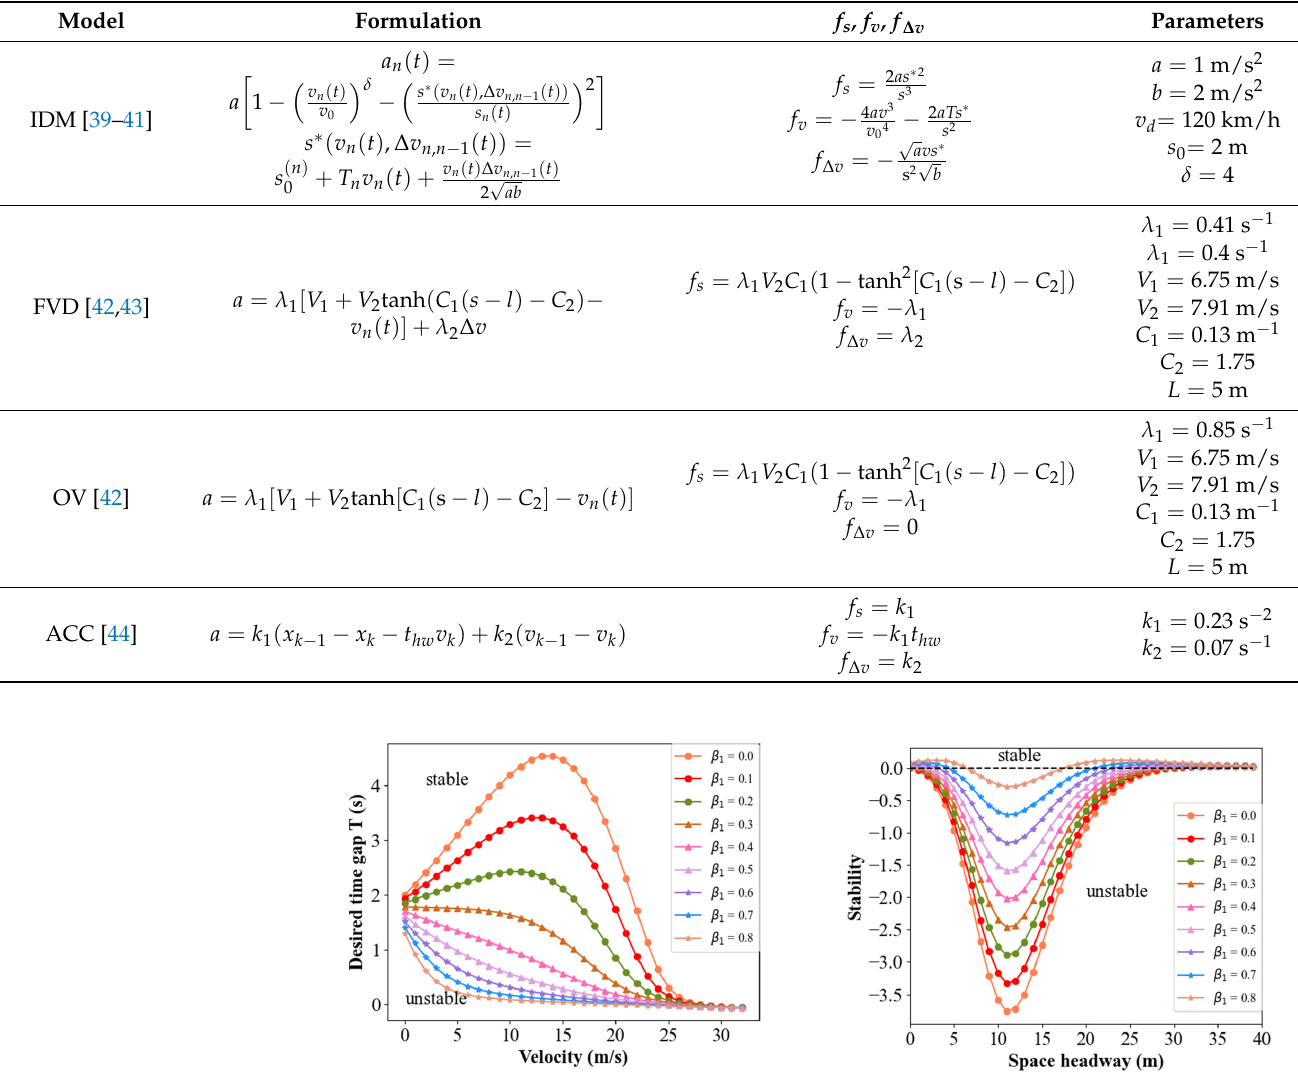
Table 1. The introduction of the four car-following models.